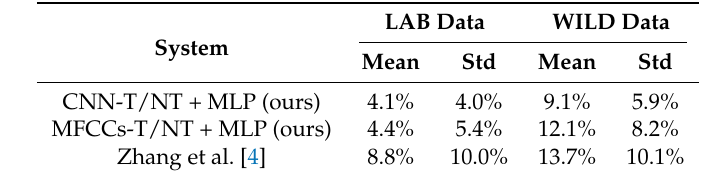
Table 5. Mean and standard deviation of the error when estimating the percentage of tremor for LAB and WILD.